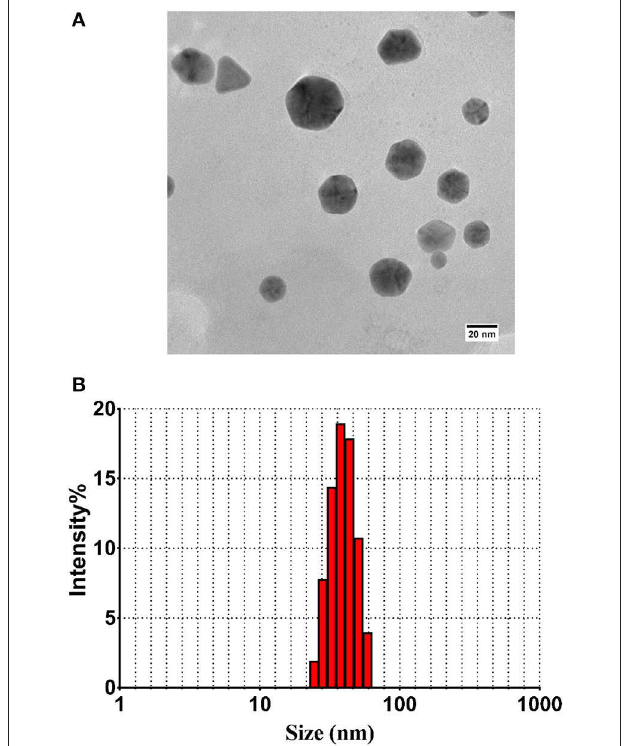
FIGURE 2 | (A) TEM analysis depicting shape and size of as-synthesized B-AuNPs: Representative TEM image of gold nanoparticles synthesized using methanolic extract of Olax scandens leaf. TEM micrograph showing simultaneous presence of hexagonal and triangular nanostructures of B-AuNPs synthesized upon incubation of Olax scandens leaf extract with aqueous HAuCl 4 . (B) Size analysis of the B-AuNPs as determined by DLS analysis: Particle size analysis with DLS (Dynamic Light Scattering) suggests overall particle radii of the as-synthesized gold nanoparticles to be approximately in the range